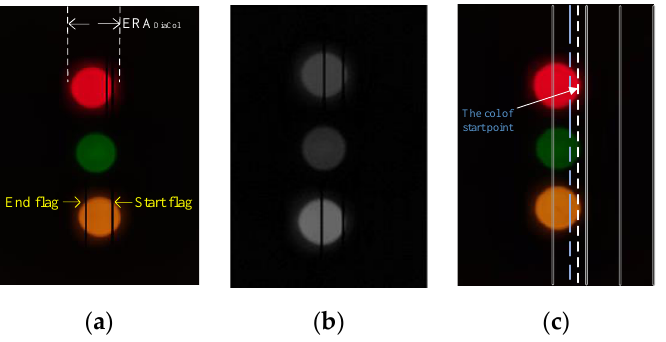
Figure 6. ( a ) Photos captured by the camera. ( b ) Image with only Y channel. ( c ) Successive approx- imation method.